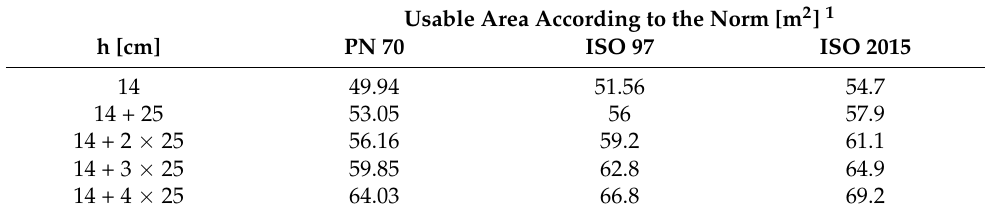
Table 2. Usable area of a top story in a building with a gable roof according to three